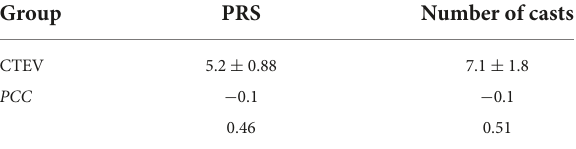
TABLE 1 Mean PRS and NC.